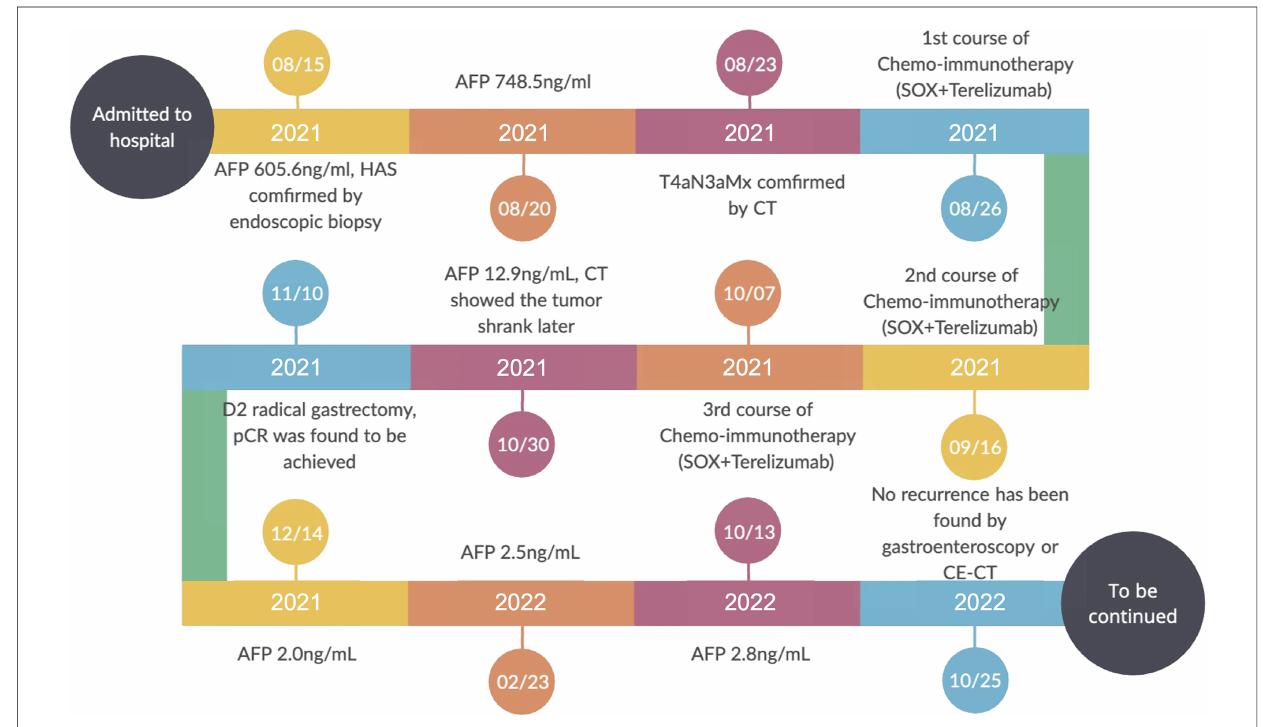
FIGURE 1 Timeline of the clinical